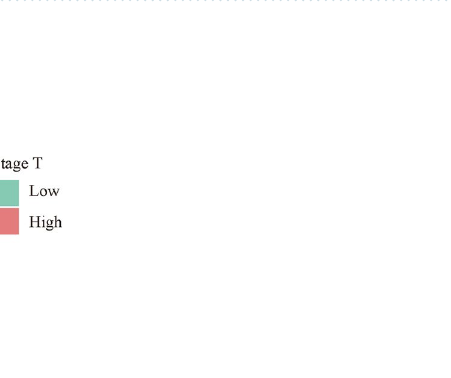
Figure 2. m5C regulatory gene correlation to clinicopathological molecular characteristics. ( A – H ) Relationship between CNVs and expression levels of m5C regulatory genes (significance P < 0.01). ( I – K ) Relationship between CNVs and expression level non-significant (ns) m5C regulatory genes.